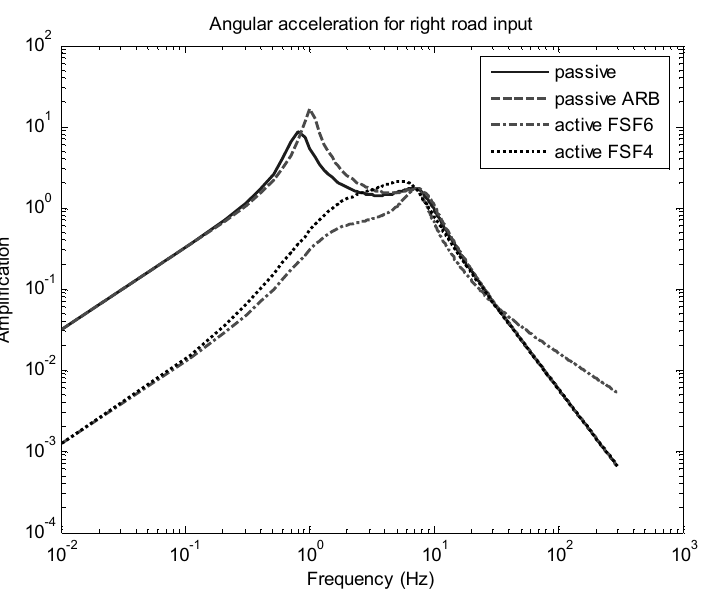
Fig. 16. Roll angle for right road input.